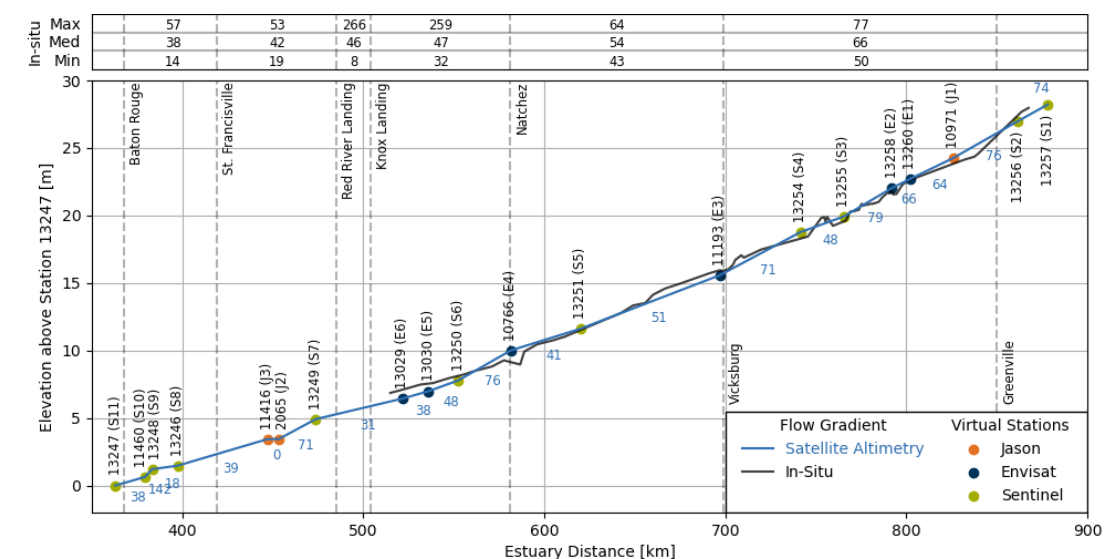
Figure 6. Flow Gradient [10 − 6 ] of the Lower Mississippi River (blue numbers) derived from adjusted virtual station elevations. A longitudinal profile derived from bathymetric survey data is shown in black. The dashed lines represent the locations of in situ water level gauges. The minimum, median, and maximum flow gradient between the gauges is shown at the